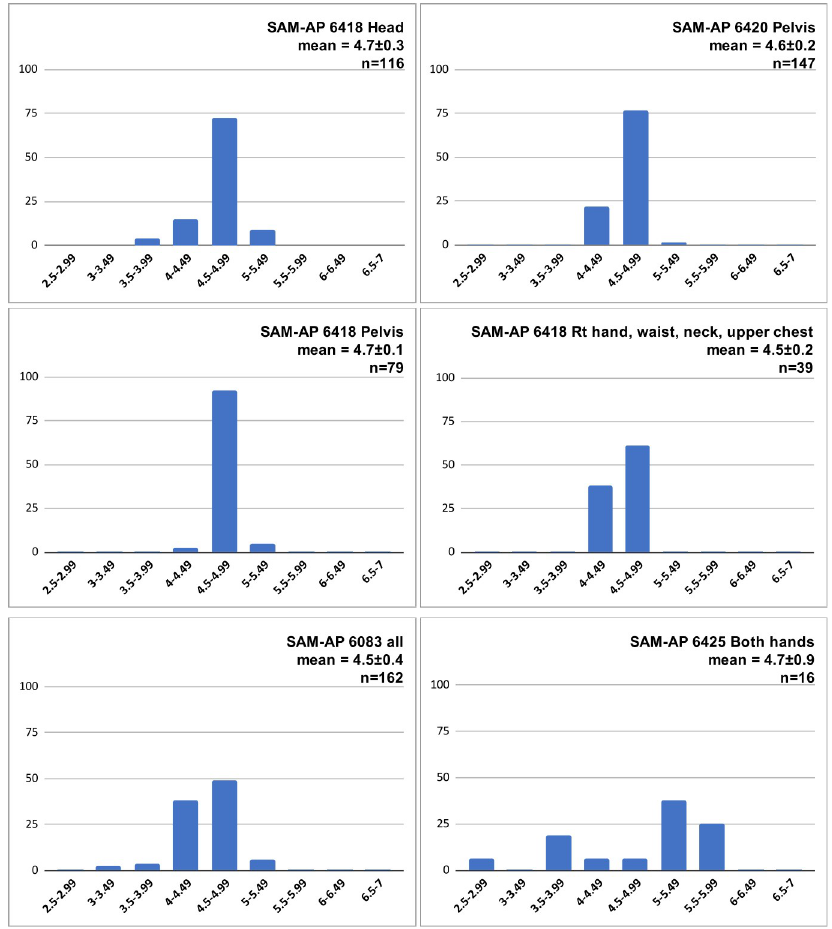
Fig 8. Histograms of maximum external diameters of OES beads: % of each sample per size category (mm).